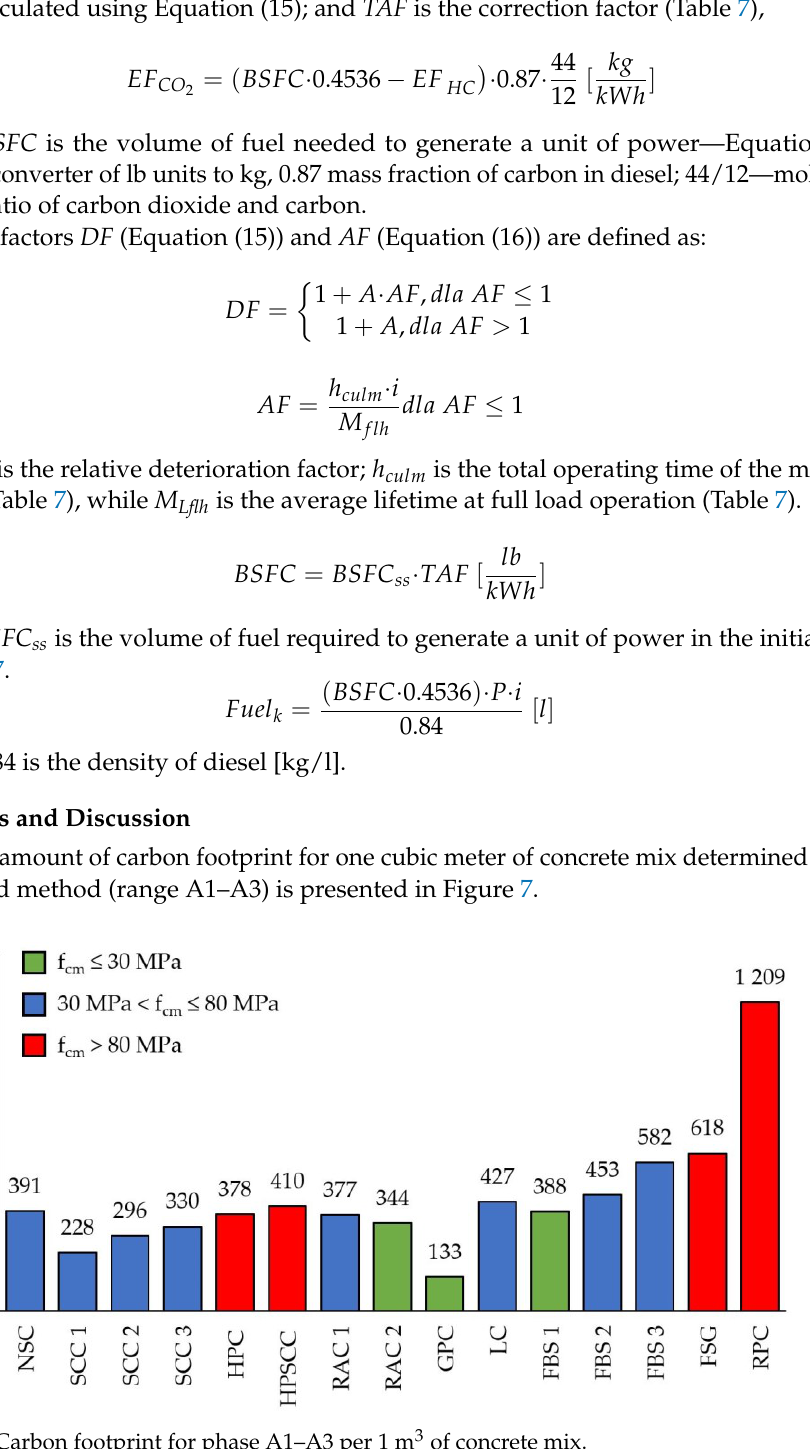
Figure 7. Carbon footprint for phase A1–A3 per 1 m 3 of concrete